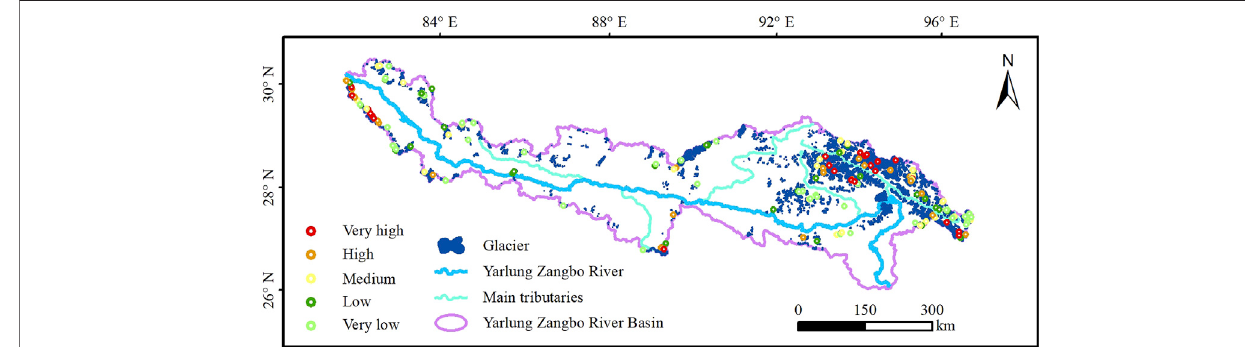
FIGURE 8 | Distribution of dangerous glacial lakes in the YZRB in 2020.